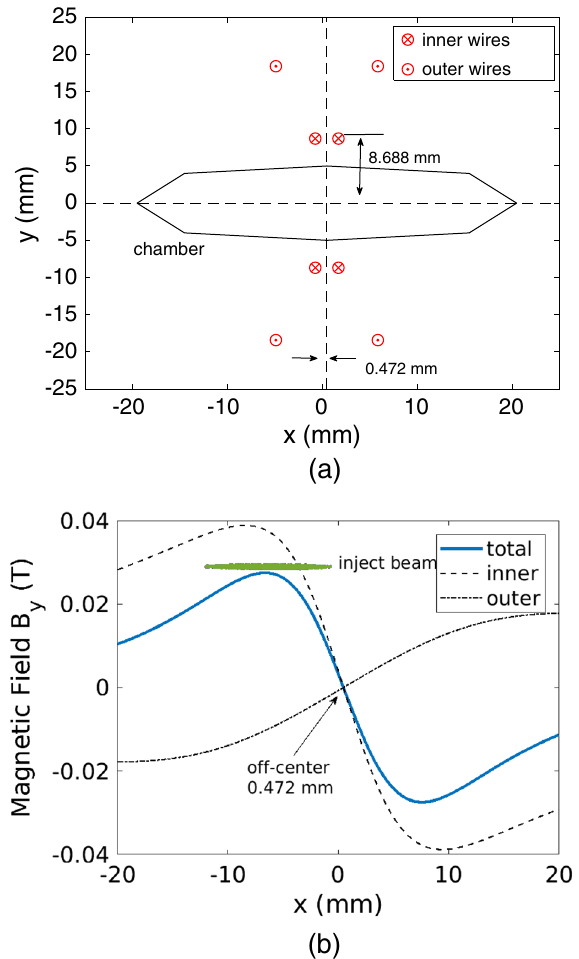
FIG. 10. The NLK conductor geometry for ALS-U (a) and its vertical magnetic field distribution (b). The vertical position of inner conductors is at 0.8688 mm and the NLK is horizontally offset by 0.472 m. The inject beam distribution at the NLK is plotted on the top of the field profile. The centroid of the beam is at 6.8 mm.